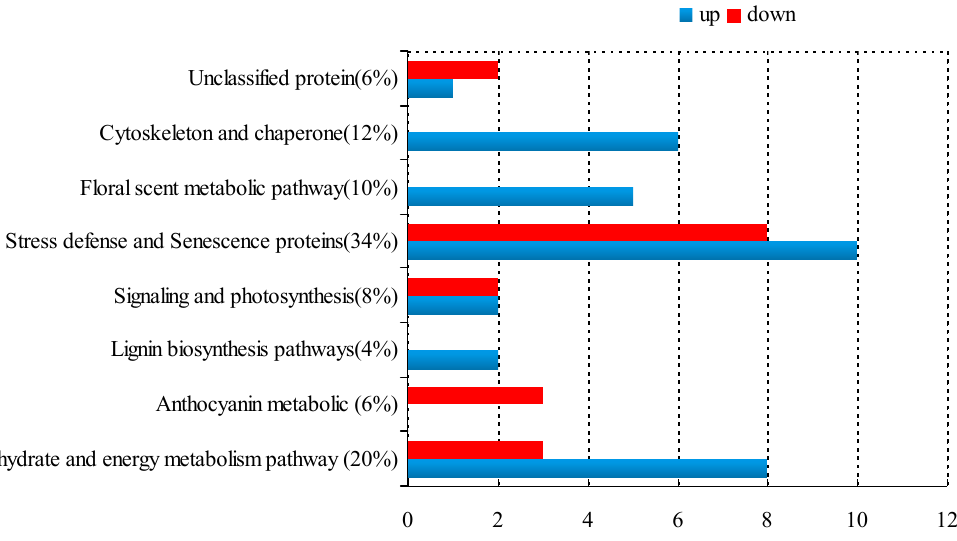
Figure 4. Functional classification and expression of identified proteins in B. acuminata petals.